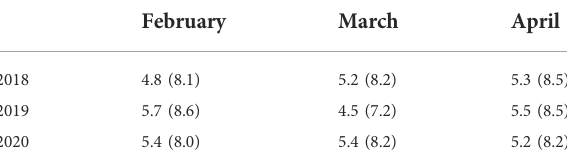
TABLE2Mean(SD)numberofdaysbetweendischargeandthestartof treatment.